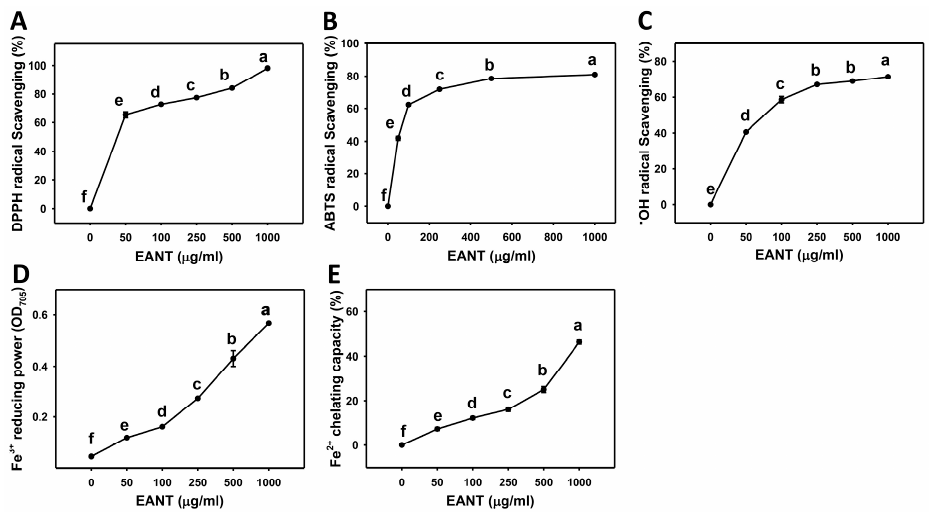
Figure 1. Concentration effect of EANT on the scavenging activities of DPPH, ABTS, and hydroxyl radical ( • OH), as well as FRAP and FCP statuses. The concentration of EANT was shown as indicated in each panel ( A – E ). Data, mean ± SD ( n = 3). For multiple comparisons, data without the same letters reveal a significant difference ( p < 0.05–0.0001). For example (Figure 1C), the • OH radical scavenging (%) at 250 and 500 µ g/mL EANT show “b and b” indicating nonsignificant differences between each other because they overlap with the same lower-case letters. Similarly, the • OH radical scavenging (%) at 50 and 250 µ g/mL EANT showing “d” and “b” indicate significant differences among each other.